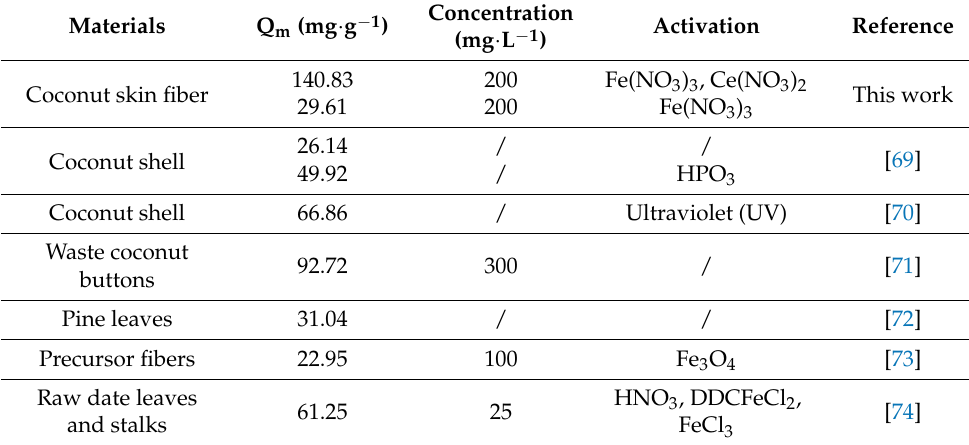
Table 6. Results of the study on the absorption capacity of adsorbed Pb 2+